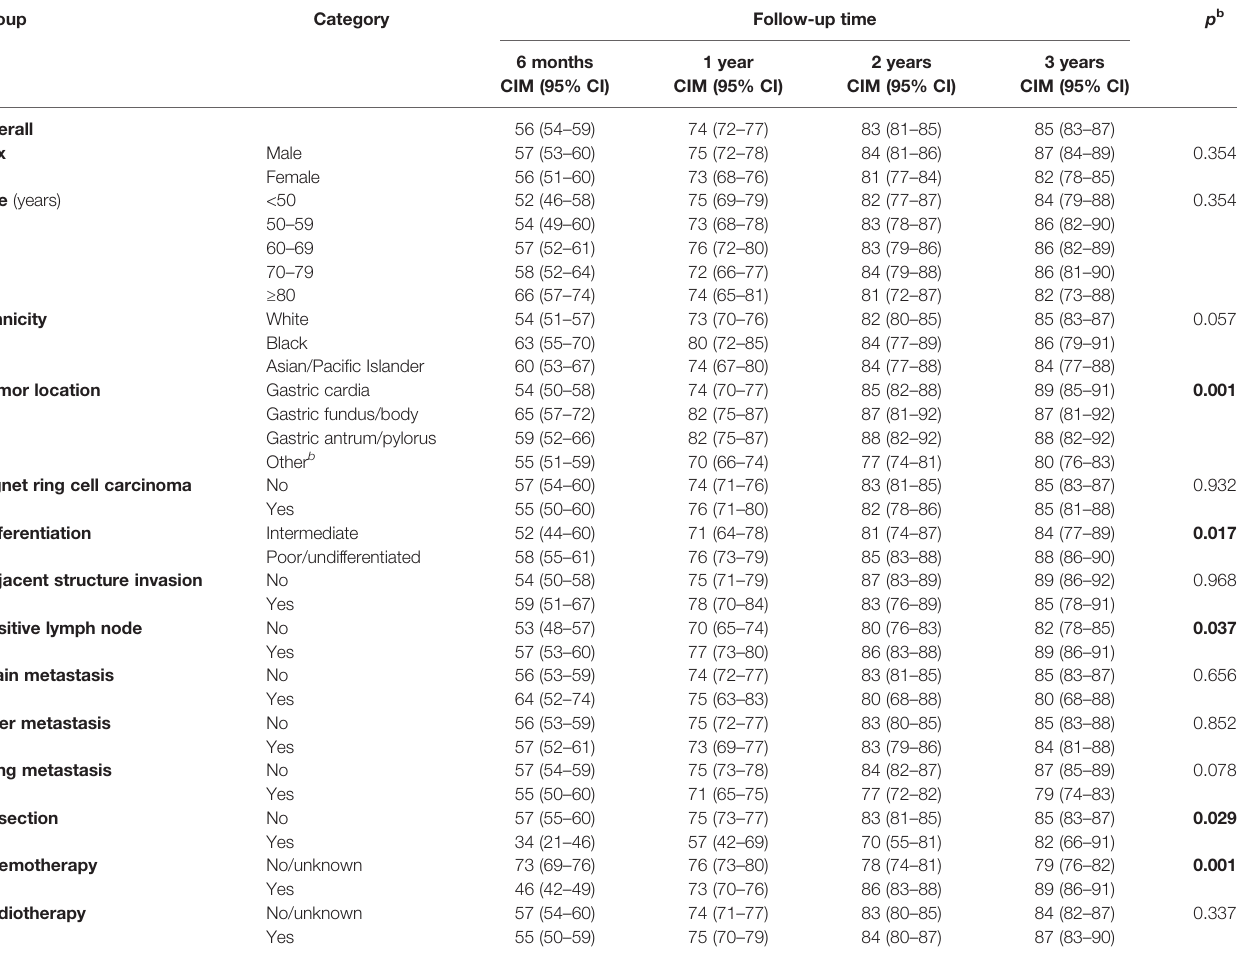
TABLE 3 | Cumulative incidences of cancer-speci fi c mortality (%) at various follow-ups in patients with gastric adenocarcinoma and bone metastasis, overall and strati fi ed a .